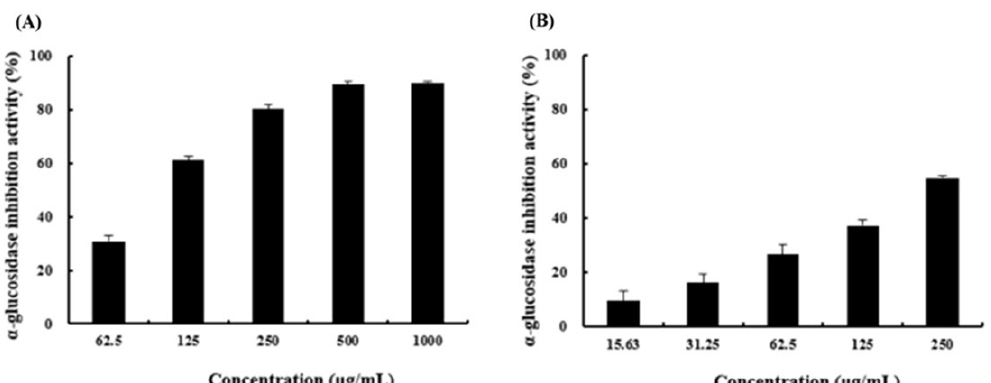
Fig. 1. α-glucosidase inhibition activities of (A) extract of B. subtilis JNUCC and (B) acarbose. The appropriate amount of acarbose was used as a positive control. The inhibition of p-Nitrophenol, a reaction product produced by α-glucosidase, was confirmed by measuring absorbance. The data are expressed as mean ± SD (n =